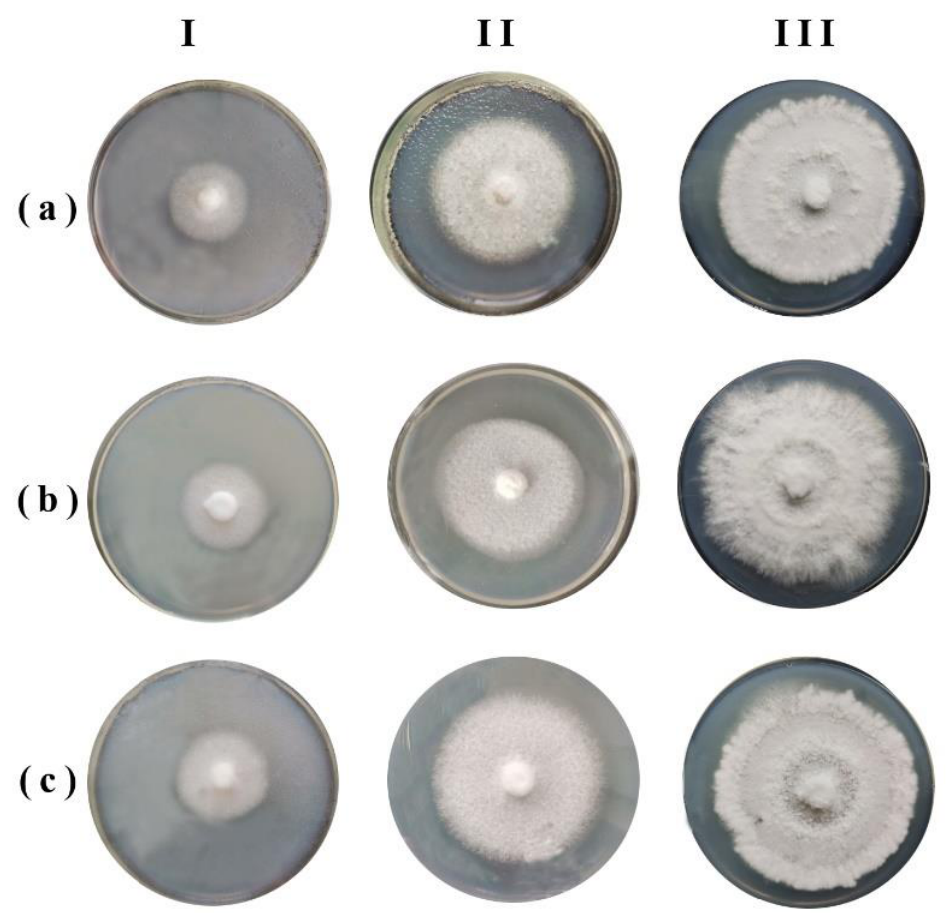
Figure 5. Growth of dikaryotic mycelium of Daedaleopsis septentrionalis in 100% CO 2 ( a ) and in 100% N 2 ( b ). I—initial size, II—after 3 days exposure in oxygen-free medium, III—after the next 3 days in air; control in air ( c ), initial size (I), after 3 (II) and 6 (III) days in air. Table 6. Growth rate (mm/day) of dikaryotic mycelium Daedaleopsis septentrionalis on wort agar in oxygen-free and air media, n = 3.